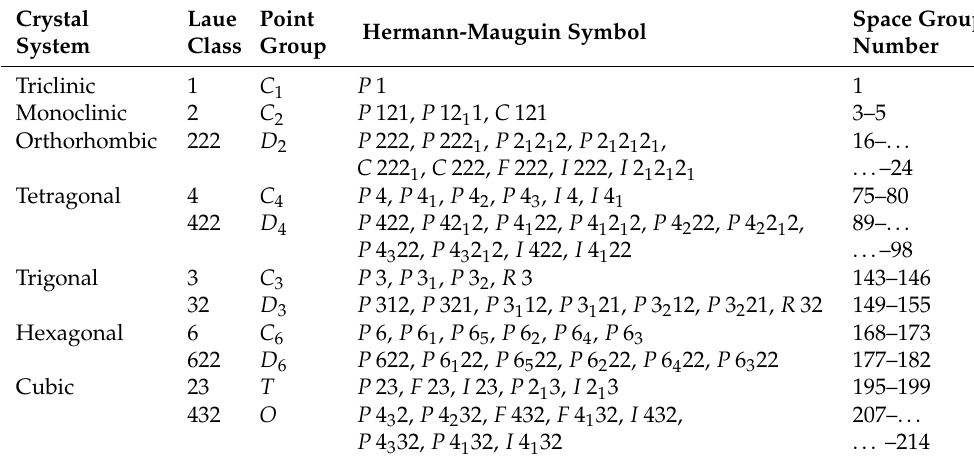
Table 2. The Sohncke groups: 65 space groups for chiral